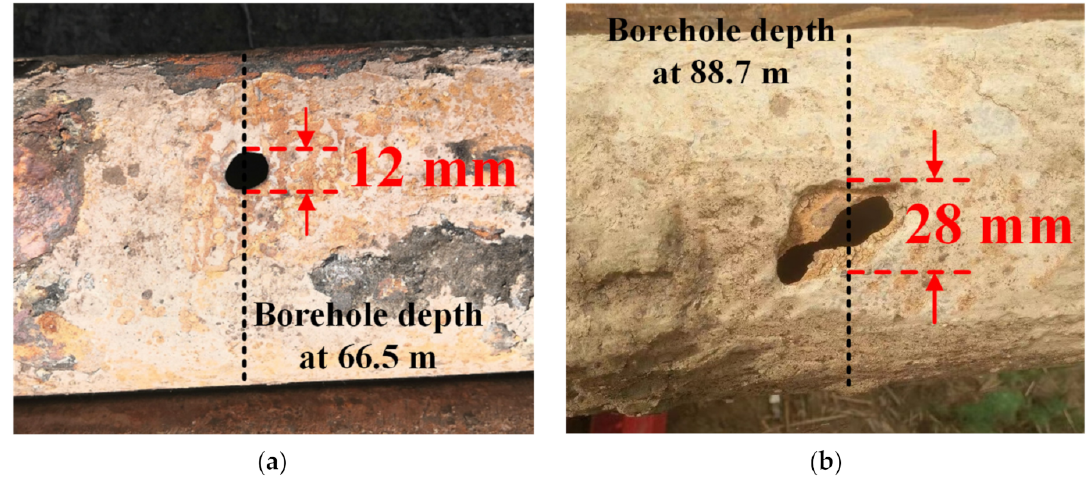
Figure 15. Actual shapes of two asymmetry defects at different depths: ( a ) 66.5 m; ( b ) 88.7